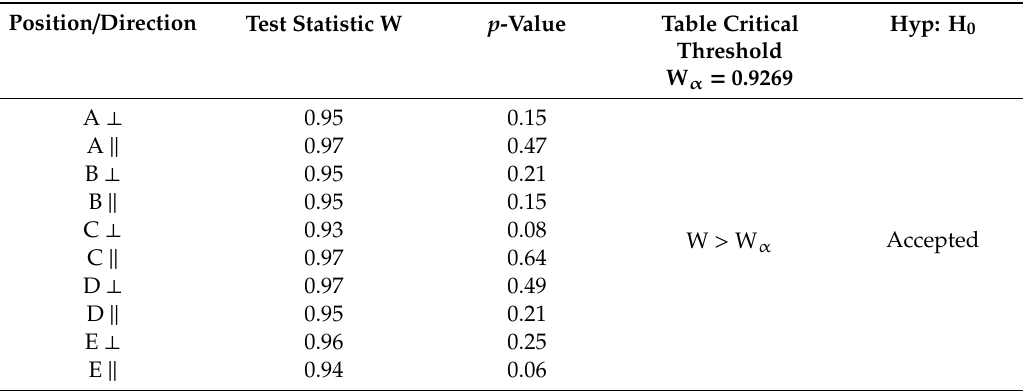
Table 2. Results of Shapiro–Wilk test of normality.